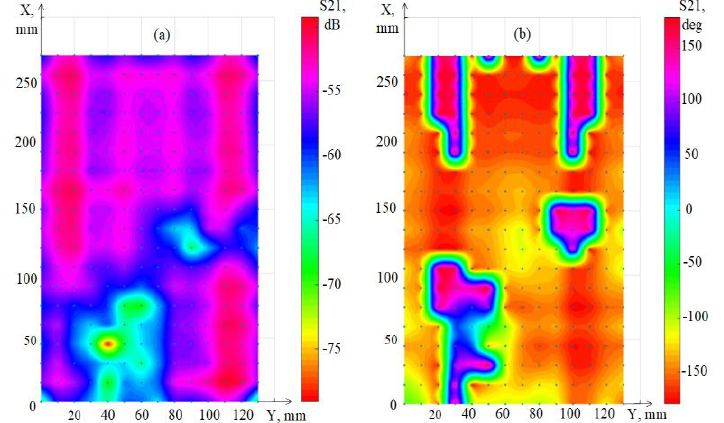
Fig. 9. Measurement results of the amplitude (a) and phase (b) of the transmission coefficient with a signal of 1500